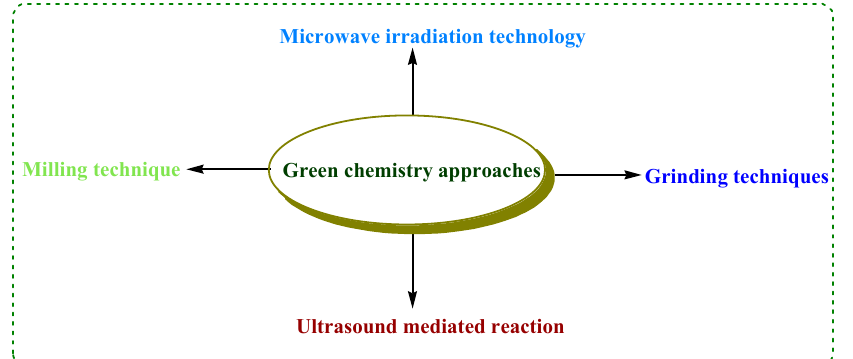
Figure 1. Green chemistry approaches.